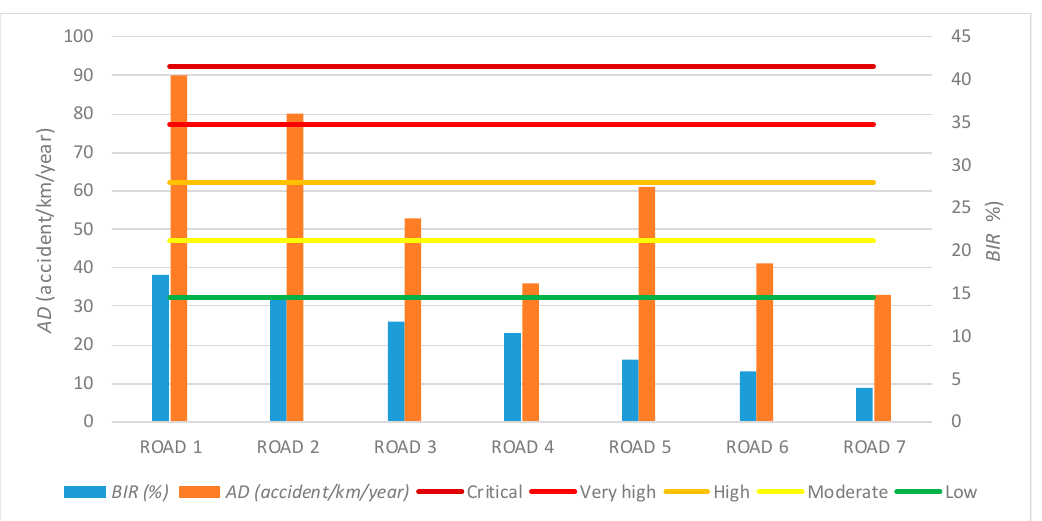
Figure 5. Comparison of BIR values and accident density for different roads.